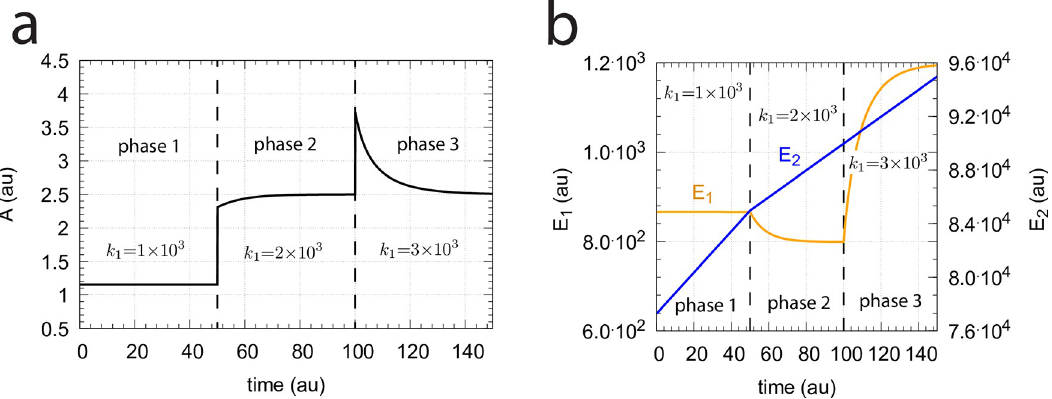
Fig 39. Under single-E control an increased perturbation k 1 moves A ss in the m5 compulsory-order ternary-complex = k 7 � Ez / k 5 . (a) Phase 1: the system is that from Fig 38d with k 6 =200 and mechanisms ( E 1 binding first to Ez ) towards A set tot k 1 =1000.0. In phases 2 and 3 k 1 is stepwise increased to respectively 2000.0 and 3000.0. In phases 2 and 3 A is moved to A set = k 7 � Ez tot / k 5 =2.5. Rate constant values as in Fig 38d. (b) Corresponding changes in E 1 and E 2 . Note the wind-up of E 2 and that only E 1 is the controller species. Initial concentrations: A 0 =1.153, E 1,0 =866.2, E 2,0 =7.728 × 10 6 , Ez 0 =4.027 × 10 − 11 , (E 1 � Ez) 0 =5.999 × 10 − 7 , and (E 1 � Ez � E 2 ) 0 =4.000 × 10 − 7